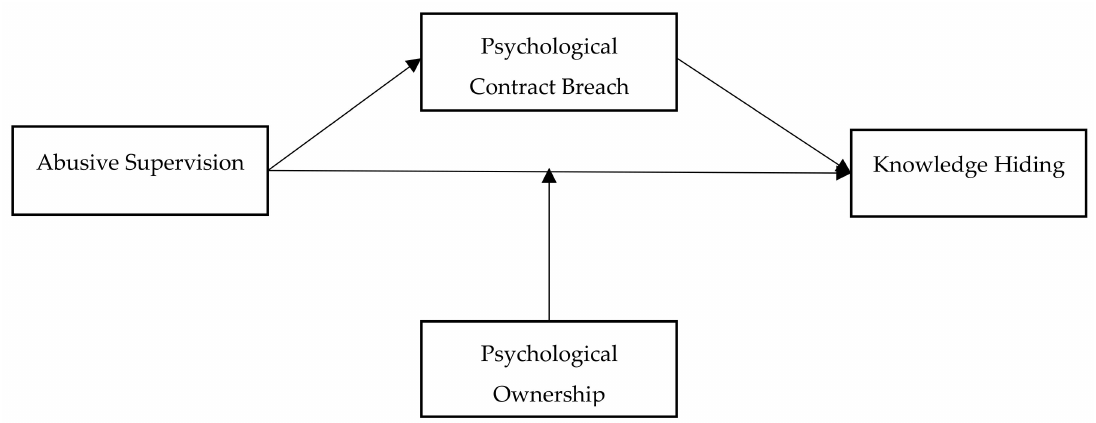
Figure 1. Proposed